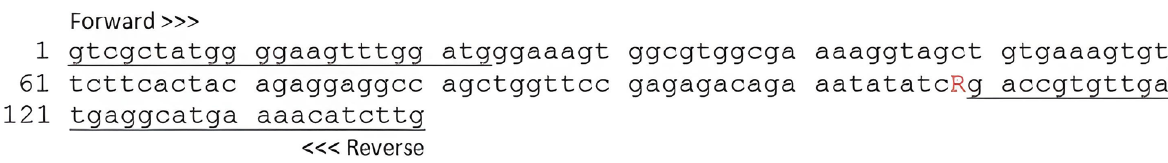
Fig. 1 Primer position (underline) in the exon 8 of ovine BMPR1B gene (GenBank: GQ863576.1) along 140 bp. A Boorola (G or Fec . B ) allele was caused by the missence mutation of c.109A > G or p.Q36R